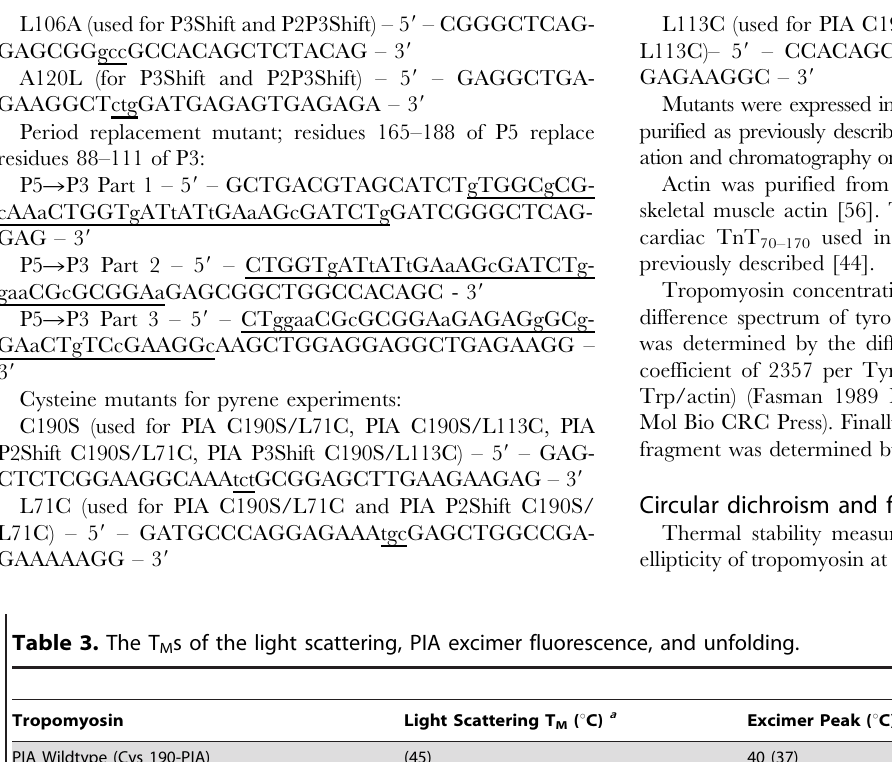
Tropomyosin Light Scattering T M ( u C)